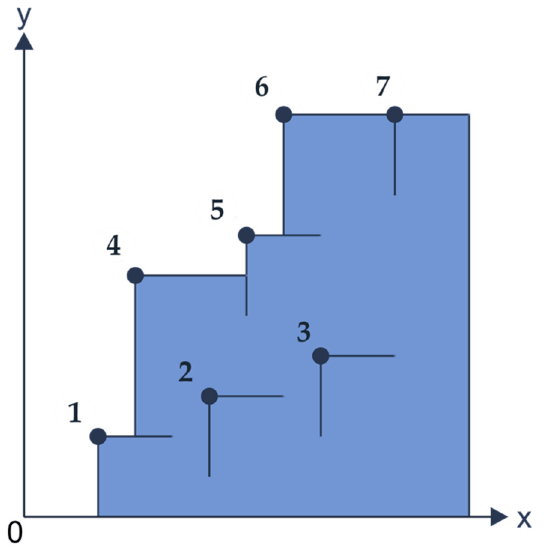
Figure 1. Production possibility sets .